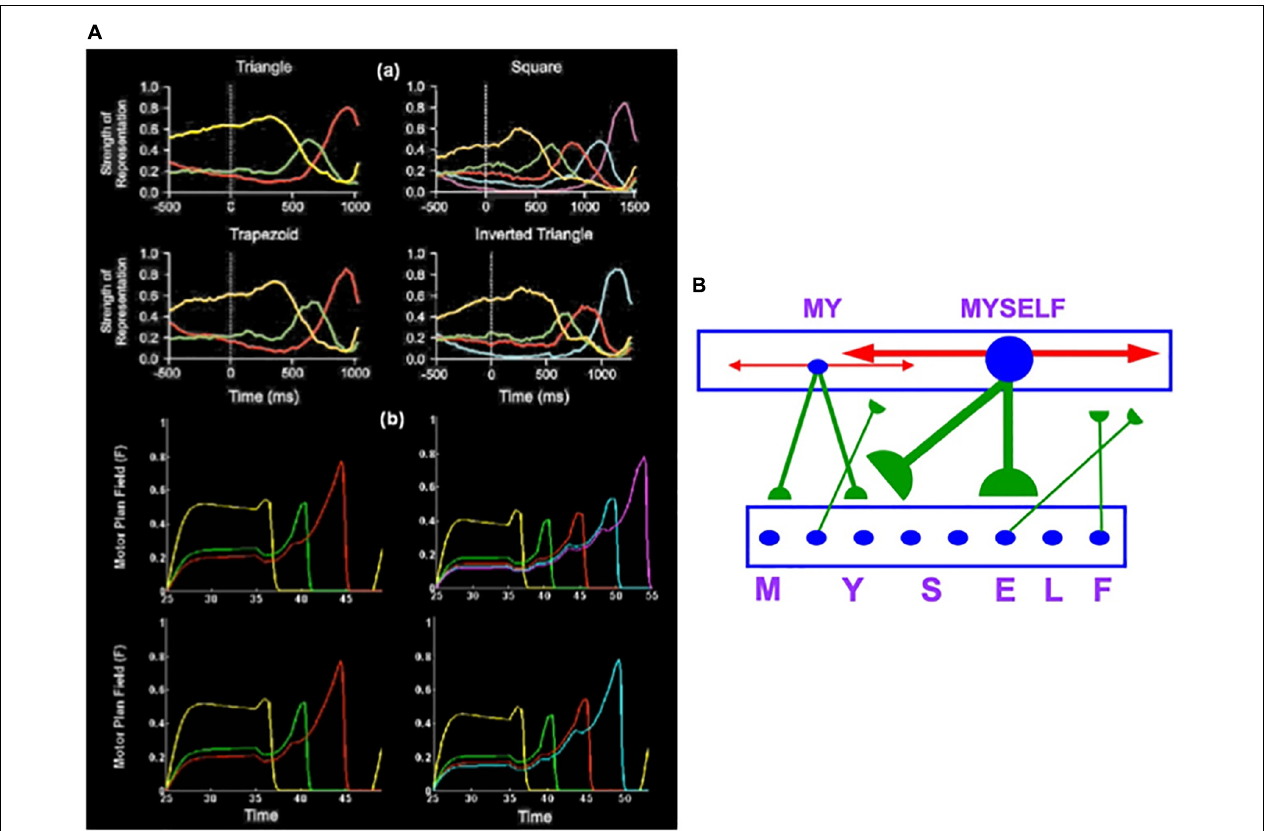
FIGURE 7 | (Aa) Neurophysiological data that conform to Item-and-Order working memory properties were recorded in a series of sequential copying experiments in monkeys [Adapted with permission from Averbeck et al. (2002)]. Each of the four figures shows a primacy gradient in working memory whose most active cell is performed first as its activity self-inhibits, followed by the next most active cell, and so on. When only the last item remains, it has the highest activity because it was freed from inhibition by earlier items. (Ab) The LIST PARSE laminar cortical model of working memory and list chunking simulates these data. [Reprinted with permission from Grossberg and Pearson (2008)]. (B) Circuit illustrating how Item-and-Order stored working memory item chunks (M, Y, S, E, L, F) activate list chunks (such as MY and MYSELF) in a Masking Field network. Masking Field cells respond selectively to lists of item chunks of variable length. How this happens is summarized in the text. [Reprinted with permission from Grossberg